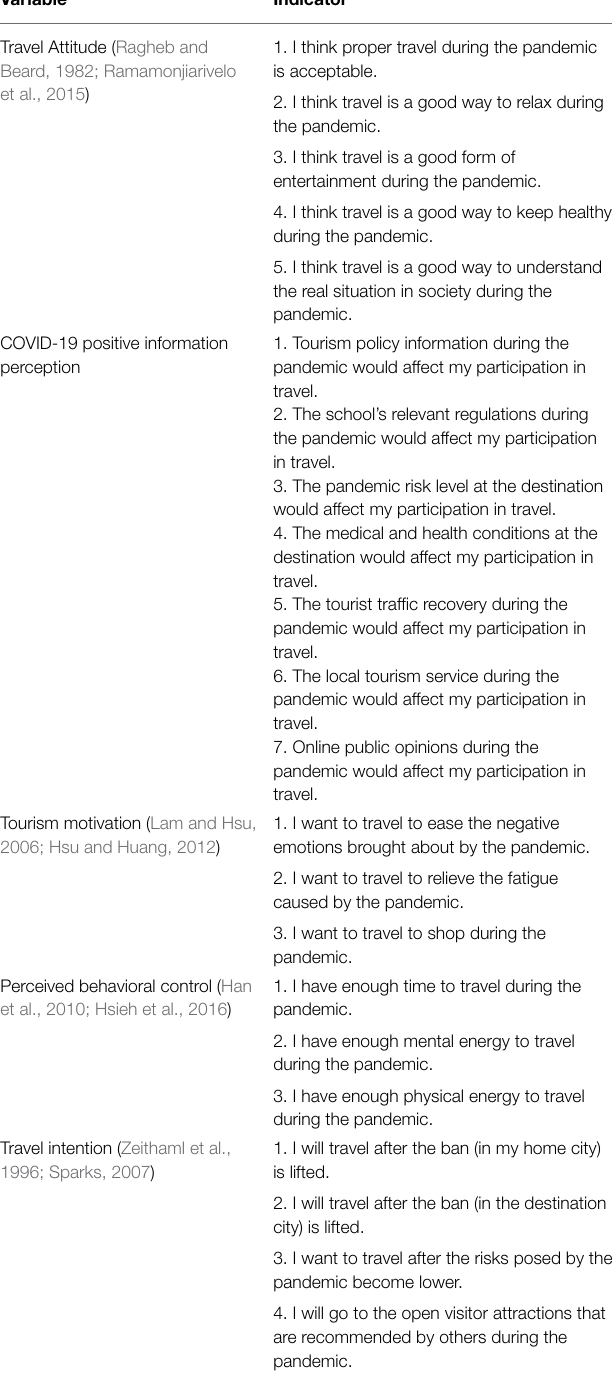
TABLE 1 | Research variables of the survey. Variable